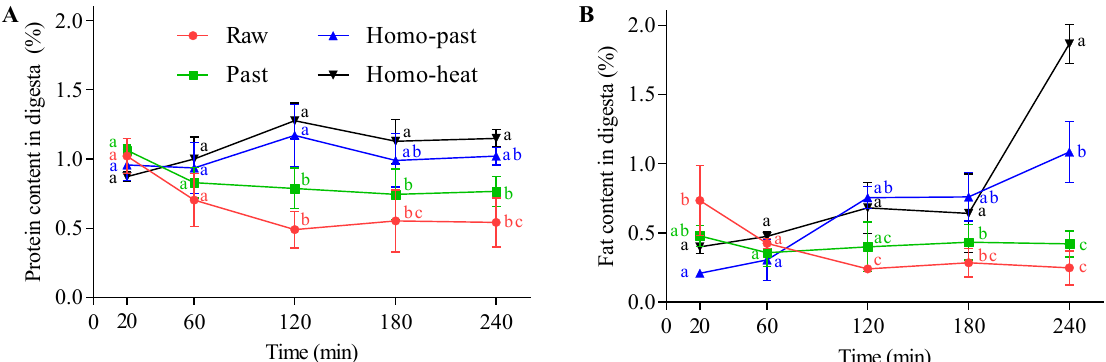
Figure 7. ( A) Protein and ( B ) fat contents in the digesta emptied at different time points (0–240 min) during the in vitro gastric digestion of differently processed sheep milks: ● , raw milk; ■ , pasteurized (Past) milk; ▲ , homogenized and pasteurized (Homo–past) milk; ▼ , homogenized and heated (Homo–heat) milk. Different lowercase letters indicate significant difference ( p < 0.05). Error bars represent standard deviations.